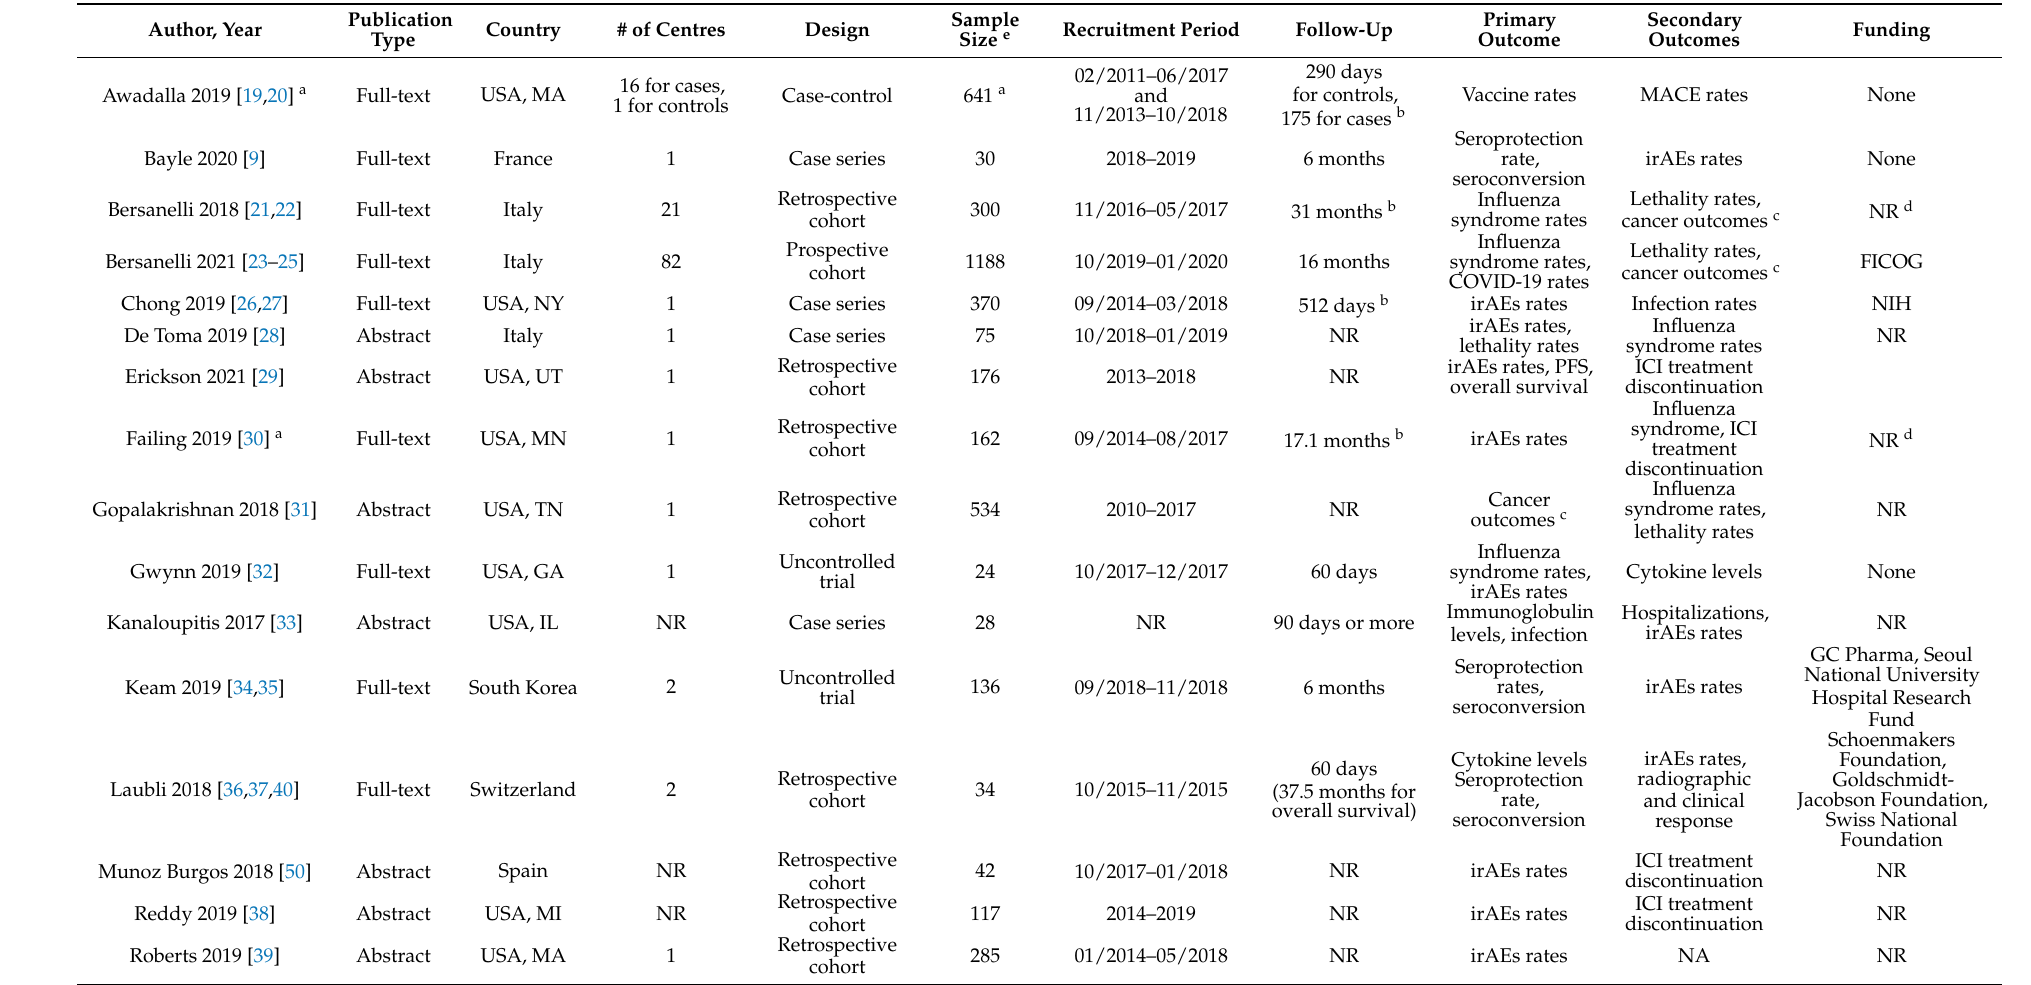
Table 1. Characteristics of the included